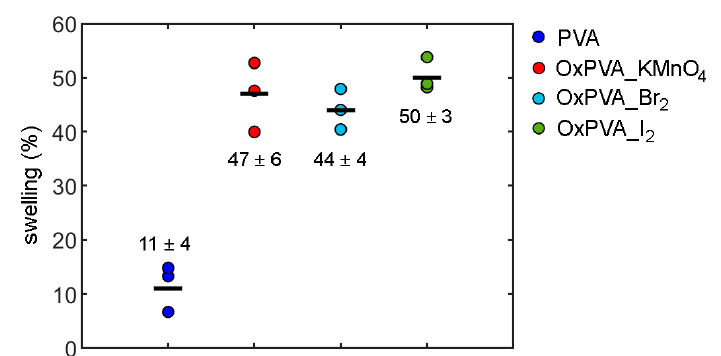
Figure 4. Swelling % for native and oxidized PVA hydrogels at equilibrium in PBS at 37 °C. For each material, the swelling ratio mean values (black dash) and the standard deviation are indicated.